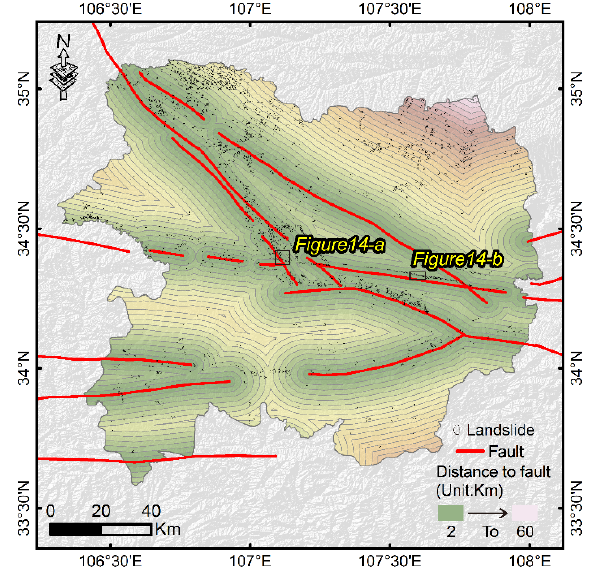
ISPRS Int. J. Geo-Inf. 2021 , 10 , x FOR PEER REVIEW Figure 11. Faults and landslide distribution in the study area. Figure 11. Faults and landslide distribution in the study area.